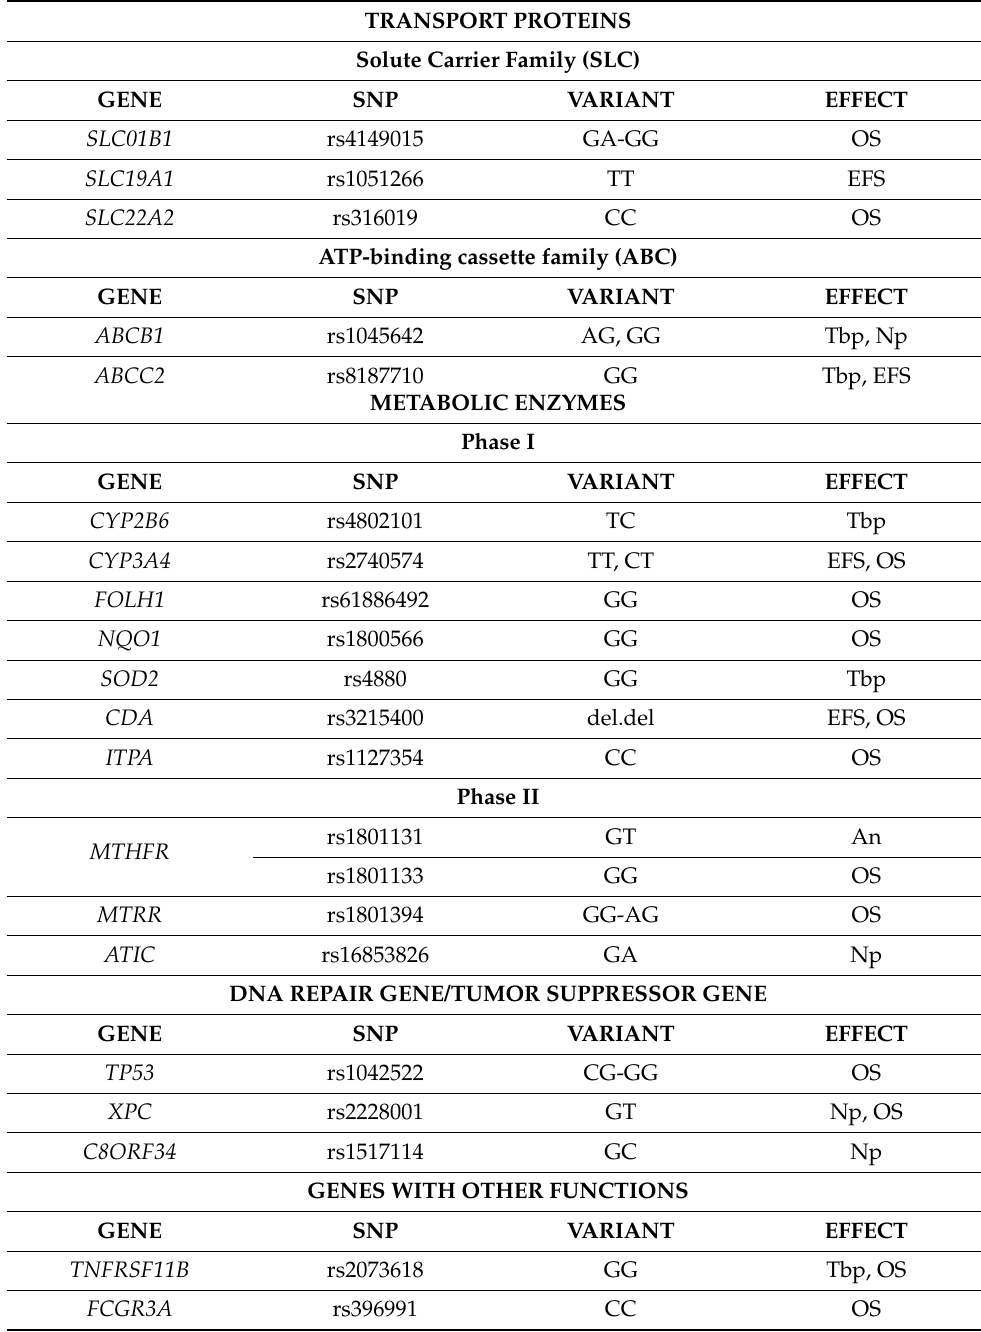
based on the function of the proteins encoded in Table 3. These biological functions are drug transporters or metabolizers (7 and 17 genes, respectively); DNA repair and/or control of tumor suppression (5 genes); and other functions (4 genes). Table 3. Classification of the genes where the more relevant associations between SNPs and toxic- ity/survival have been found, according to the main function of the protein (transport, metabolism, DNA reparation, tumor suppression, or other biological functions). SLC: Solute carrier family; ABC: ATP-binding cassette family; EFS: event-free survival; OS: overall survival; Tbp: thrombocytopenia; An: anemia; Np: